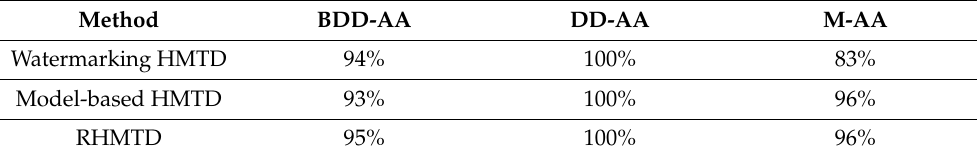
Figure 11. The projection of RHMTD and no MTD measurements in the ℝ 2 space. Table 2. DSP of existing HMTD methods and the RHMTD against three alert